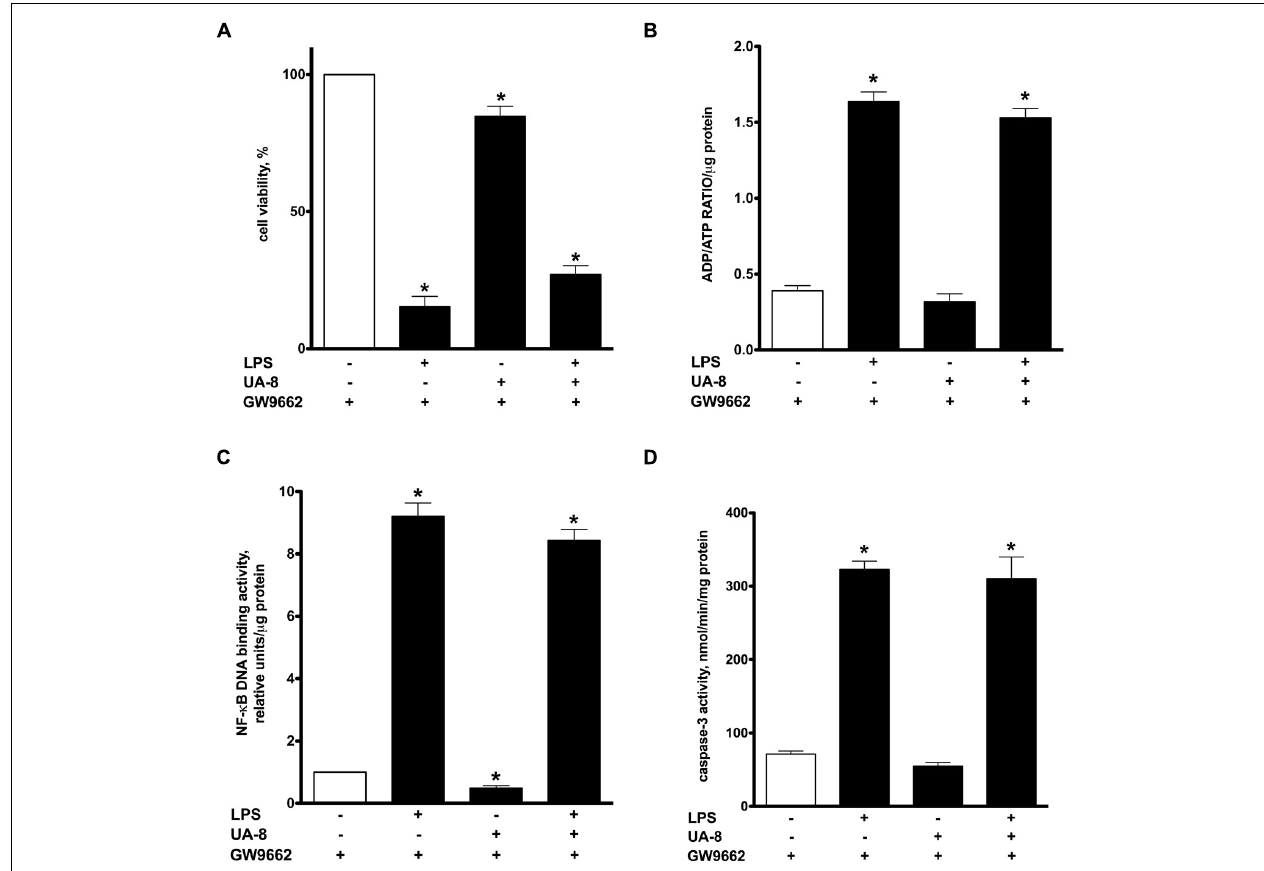
FIGURE 5 | Pharmacological inhibition of PPAR γ significantly prevented UA-8 associated protective effects in LPS-induced cytotoxicity. NCMs were treated with LPS (1 μ g/ml) and/or UA-8 (1 μ m) in the presence of GW 9662 (1 μ m) for 24 h. (A) Pharmacological inhibition of PPAR γ prevented protective effect of UA-8 on cell viability. (B) Inhibition of PPAR γ abolished protective effect of UA-8 on ADP/ATP ratio in NCMS